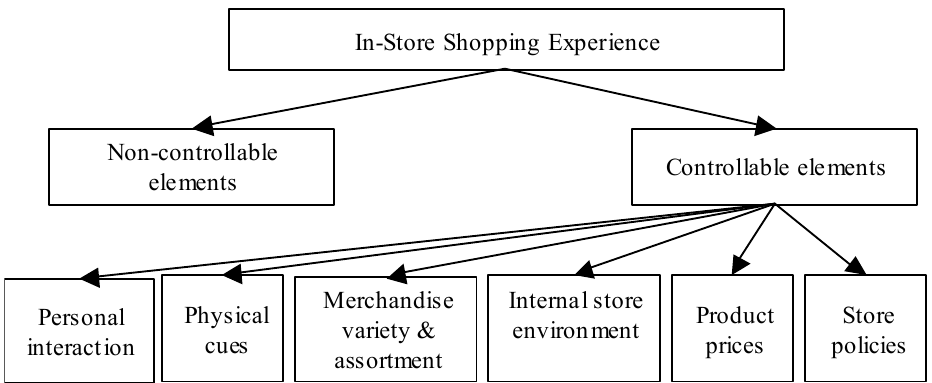
Figure 1: Schematic presentation of the dimensions of ISE tested in the second phase of the study